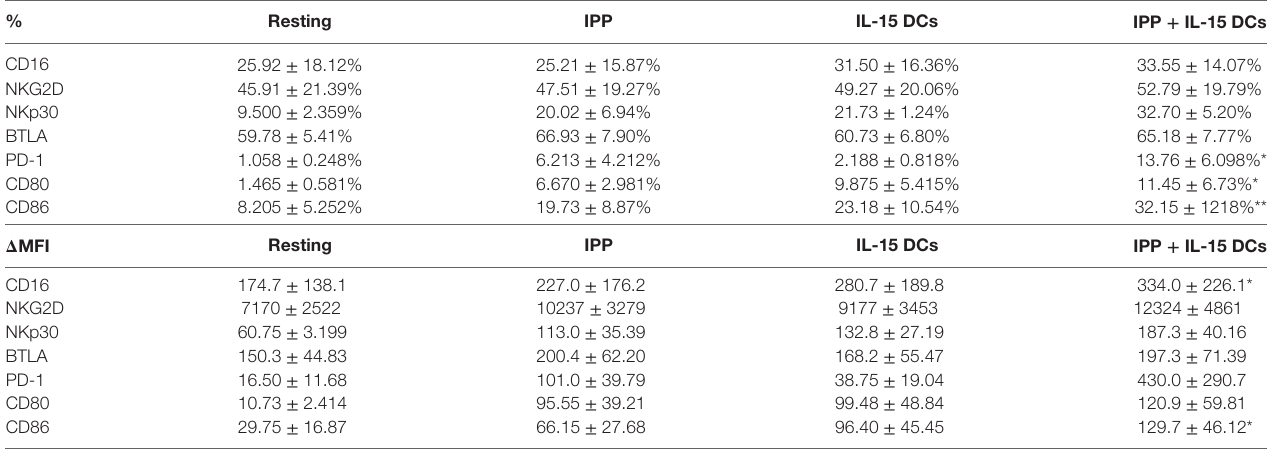
TaBle 3 | γδ T cell phenotype of acute myeloid leukemia patients 48-hours after co-culture with IPP, IL-15 dendritic cells (DCs) or both. %